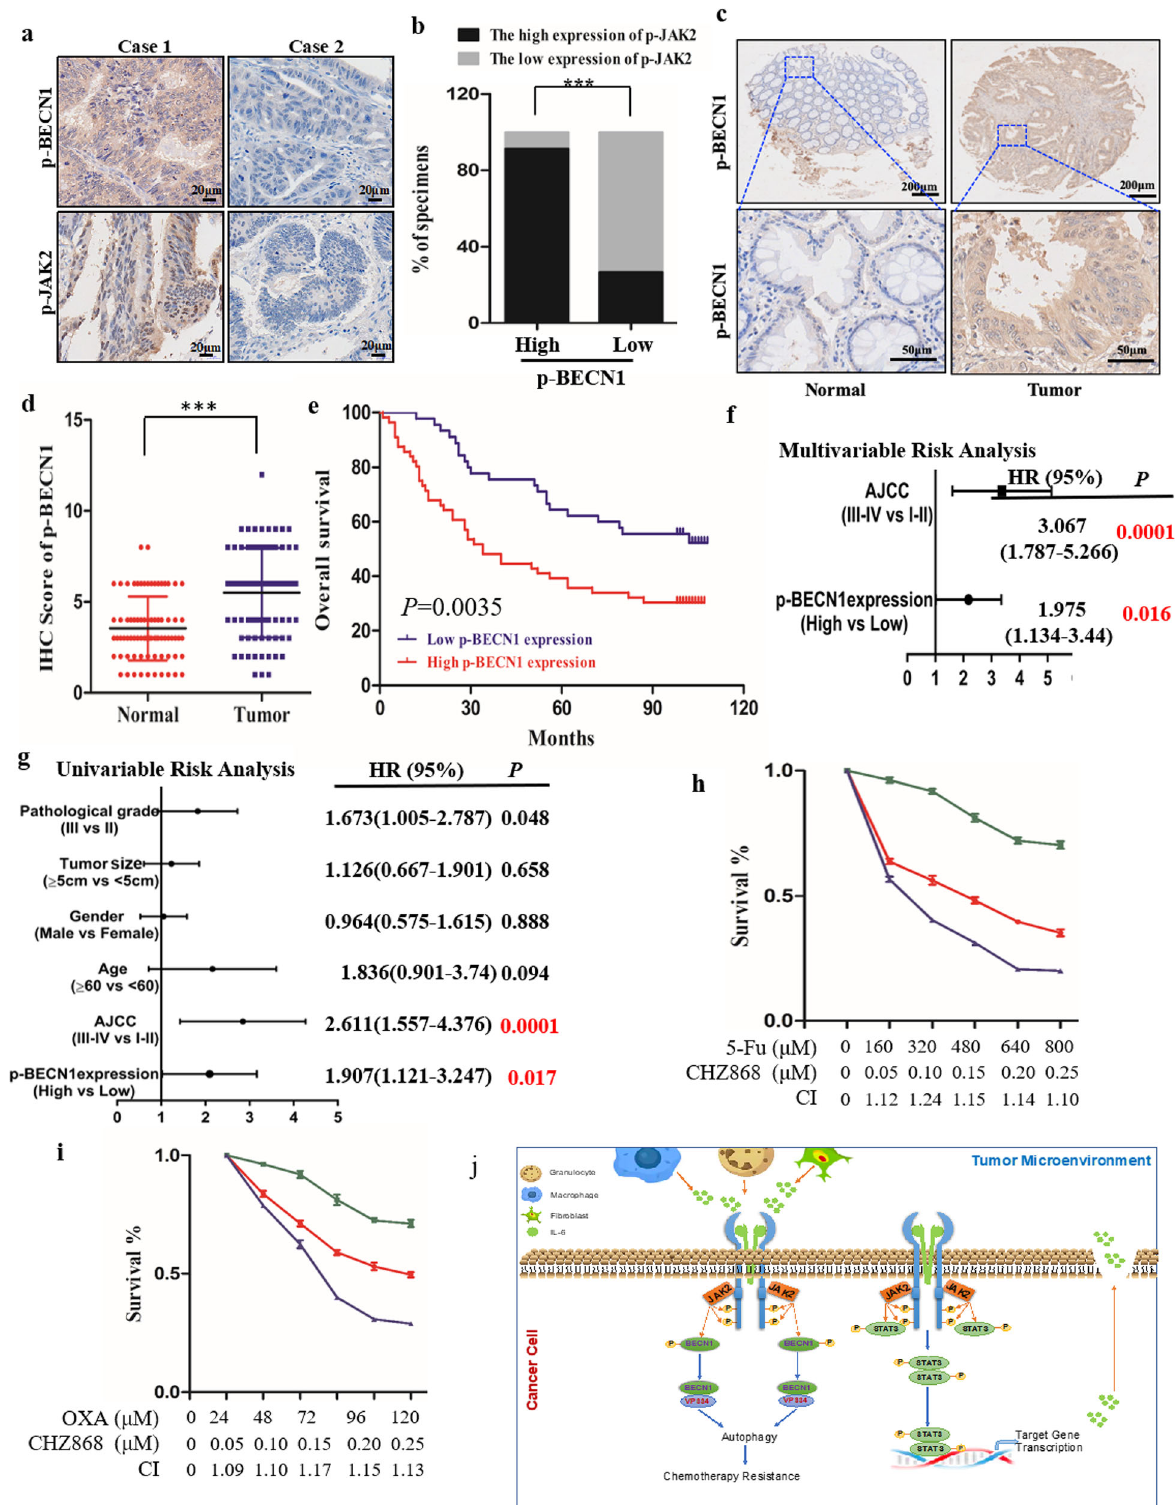
complemented groups, and Y331F Becn1 complementation only had a slight effect on autophagy (Fig. 6j and Supplementary Fig. 7d). Taken together, these data indicate that p-BECN1 (Y333) plays an important role in IL-6-induced CRC chemotherapy